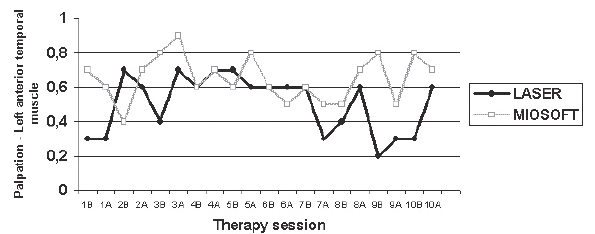
FIGURE 4- Mean palpation figures (from 0 to 3) of the left anterior temporal muscle, before and after each therapy session